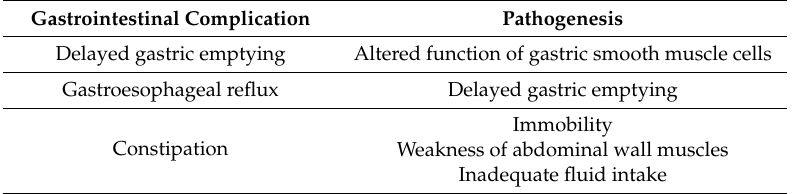
Table 3. Gastrointestinal complications in patients with neuromuscular diseases (NMDs).